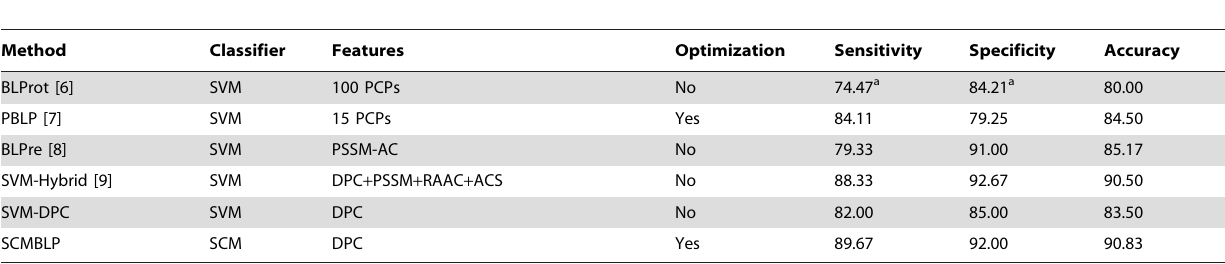
Table 2. The comparisons of SCMBLP with some comparable methods using BLP-TRN in terms of 5- or 10-fold cross-validation accuracy (%).